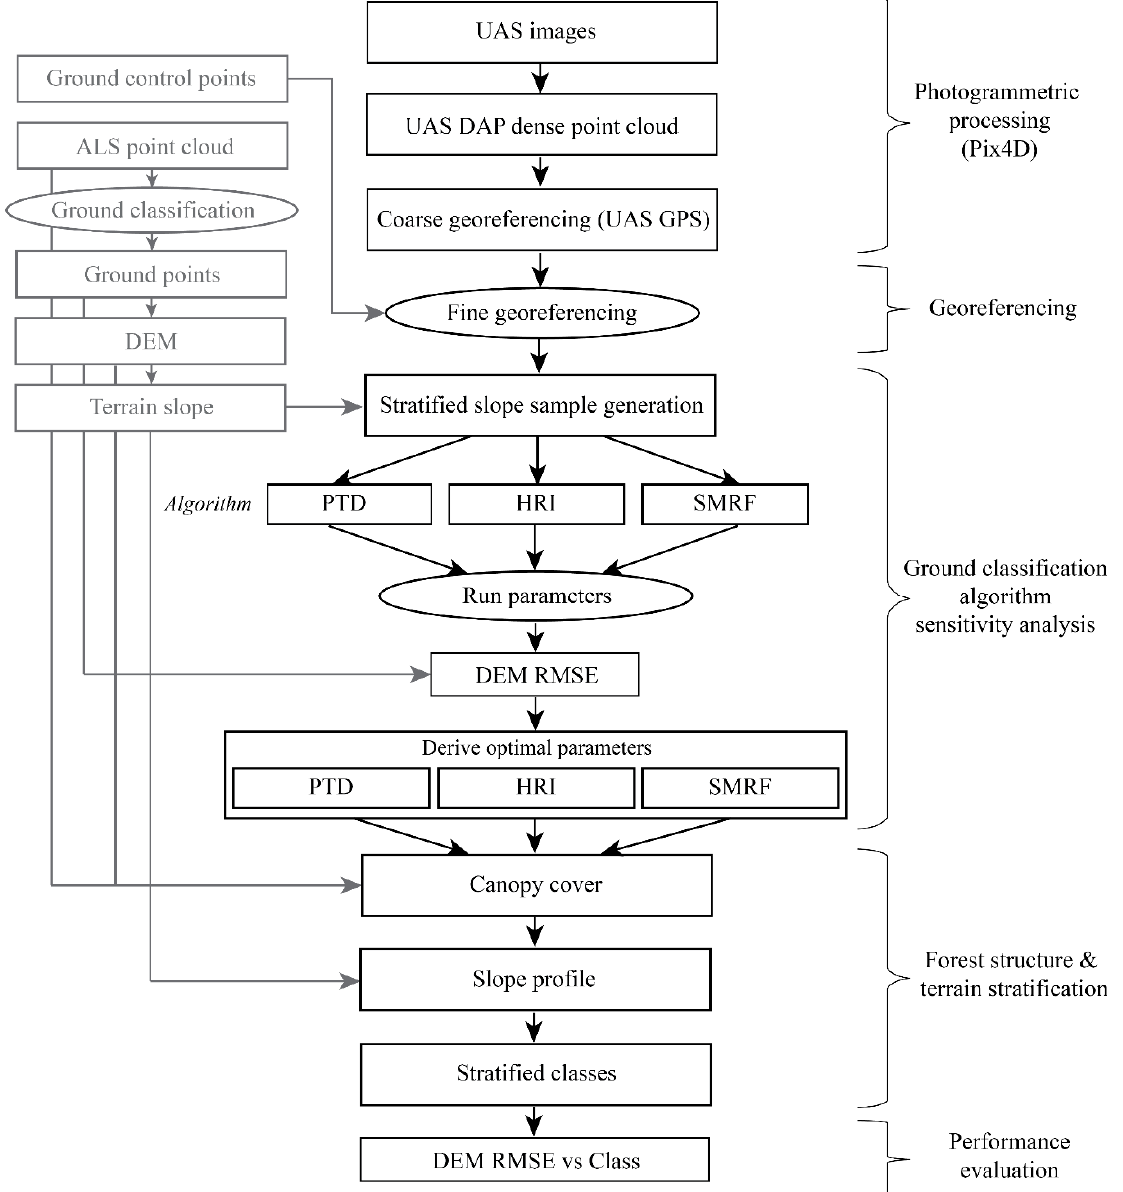
Figure 1. Schematic workflow of DAP point cloud generation, ground filter sensitivity analysis and DEM error assessment.